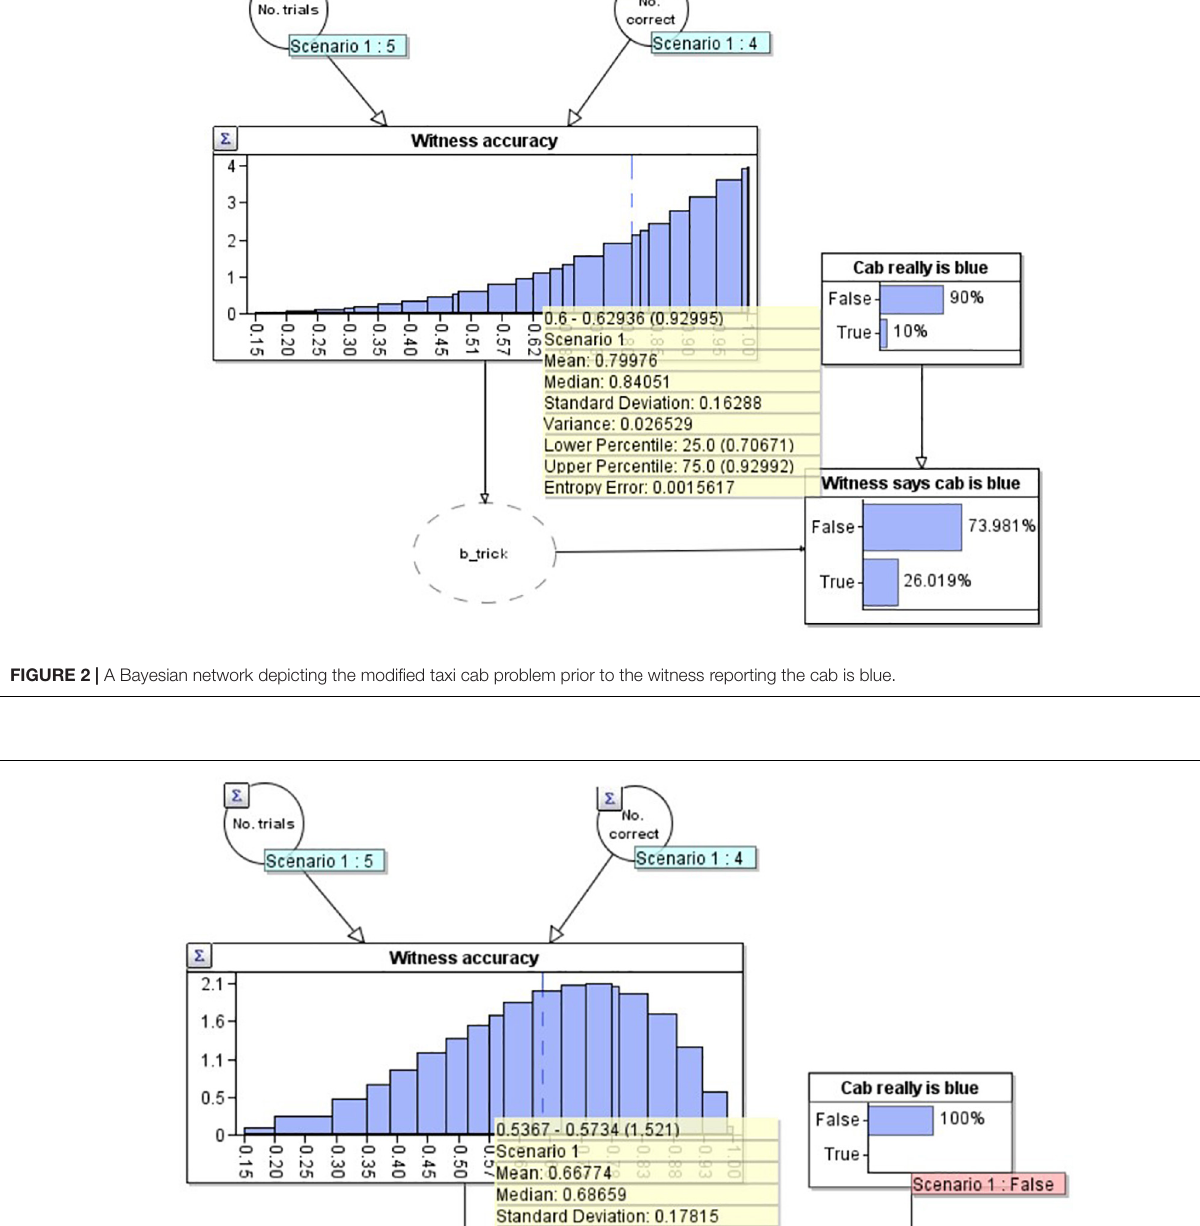
Frontiers in Psychology |